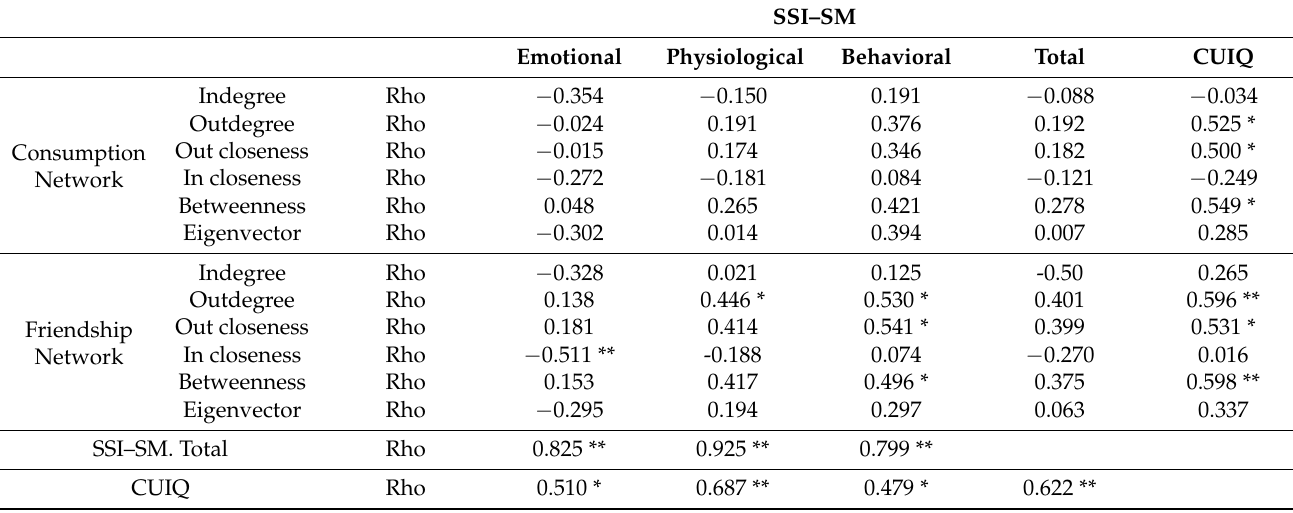
Table 4. Correlations between centrality metrics of friendship and consumption networks, stress and cannabis use